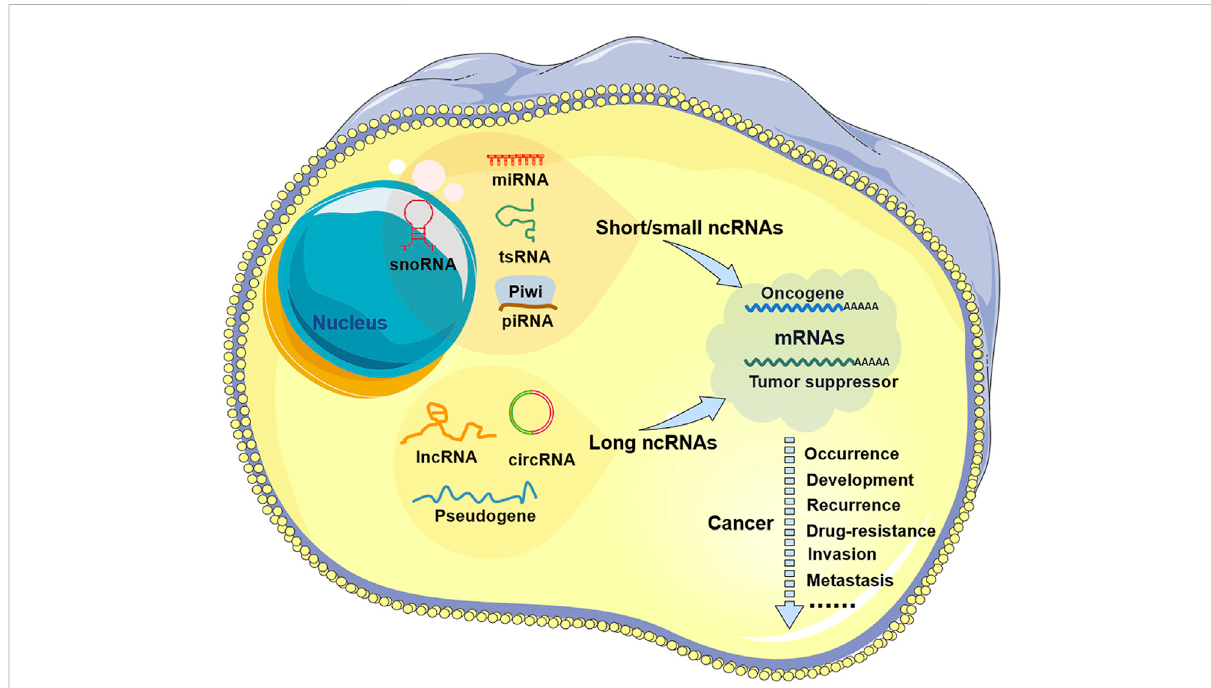
FIGURE 1 NoncodingRNAintumors.Therearetwotypesofnon-codingRNAs(ncRNAs)intumorcells:short/smallncRNAsandlongncRNAs.Short/small ncRNAs include at least four types: microRNAs (miRNAs), small nucleolar RNAs (snoRNAs), transfer RNA-derived small RNAs (tsRNAs), and piwi- interacting RNAs (piRNAs). Long ncRNAs include common lncRNAs, circular RNAs (circRNAs), and pseudogenes. These ncRNAs are aberrantly expressed in all types of human cancers and are involved in tumor progression, including tumor occurrence, development, recurrence, drug resistance, invasion, and metastasis.